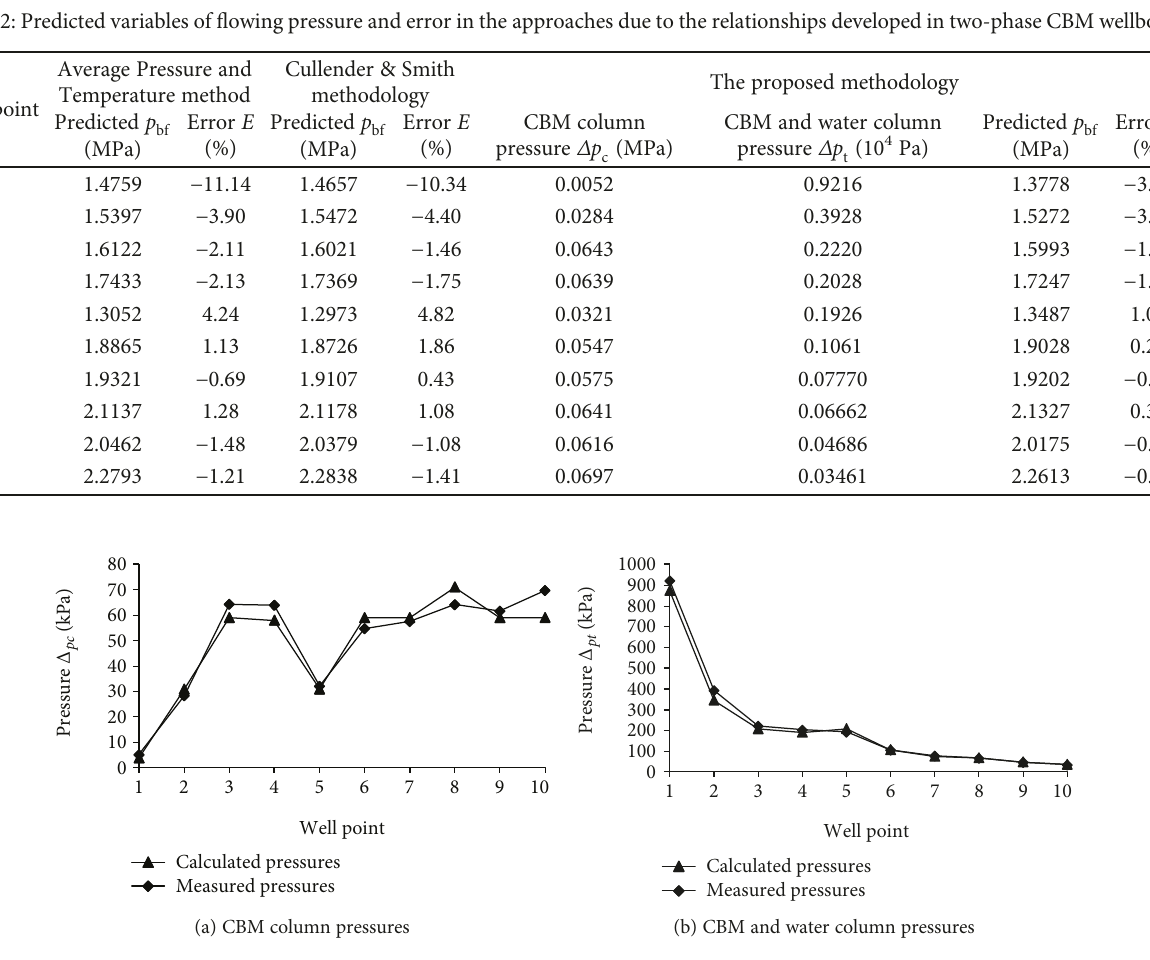
Figure 2: Comparison of predicted and measured fl owing pressures of CBM and the water